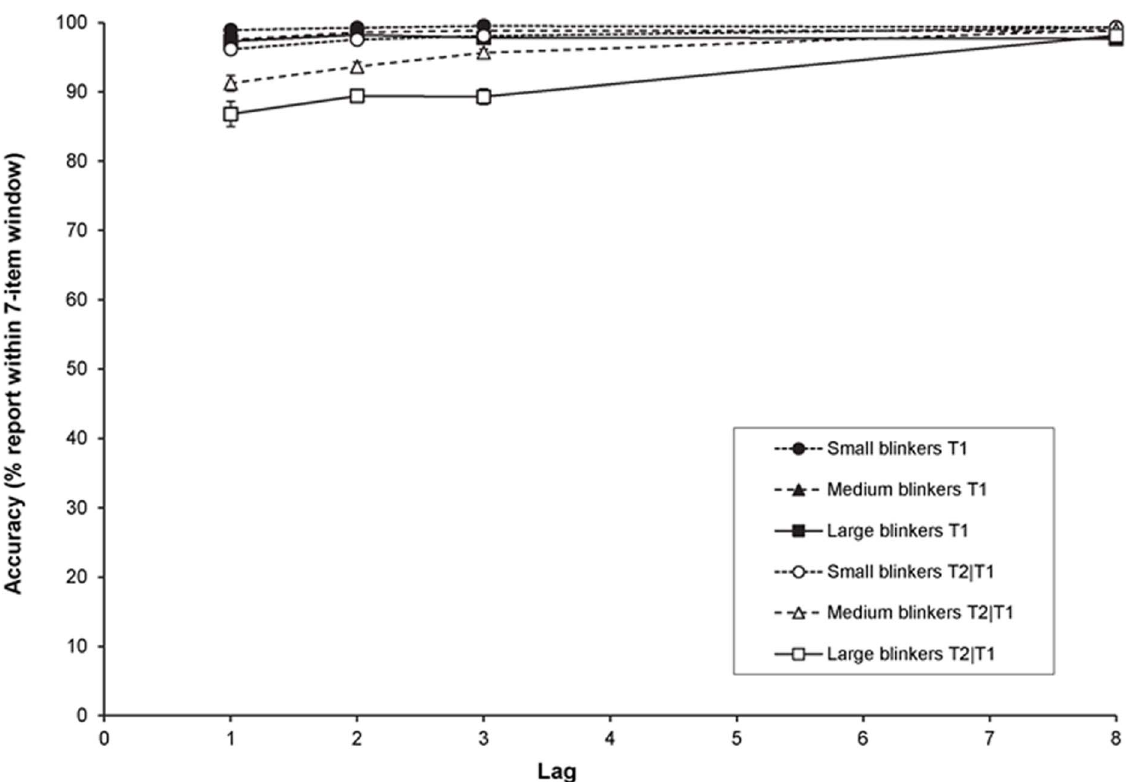
Figure 9. Suppression in Experiment 2. Suppression of the temporal selection process expressed as the accuracy of reporting an item within the 7-item window around a given target as a function of lag, for small, medium, and large blinkers.